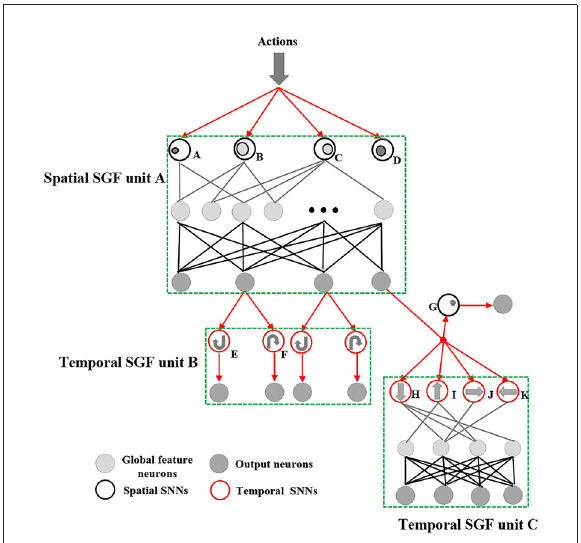
FIGURE2 The spiking gating flow (SGF) network architecture. It mainly consists of three SGF units: a spatial SGF unit A and temporal SGF units B and C. A spatial SGF unit A has four SNNs with feature ID index A-D (A: intensive activities at constrained left areas; B: mild activities at plateau left areas; C: mild activities at plateau right areas; D: intensive activities at constrained right areas). A temporal SGF unit B has two SNNs with feature ID E,F (E: clockwise movement; F: counter-clockwise movement). A temporal unit C has four SNNs with feature ID index H-K (H: top-down; I: bottom-up; J: left-right; K: right-left). Also,